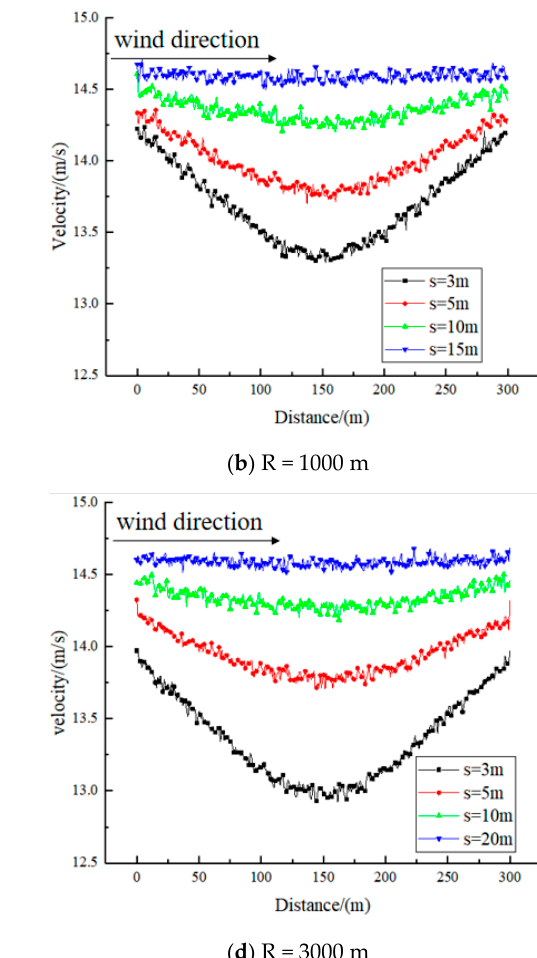
( b ) Y = 150 m Figure 9. Flow-field distribution of embankment cross-section at different line positions on convex windward curve.